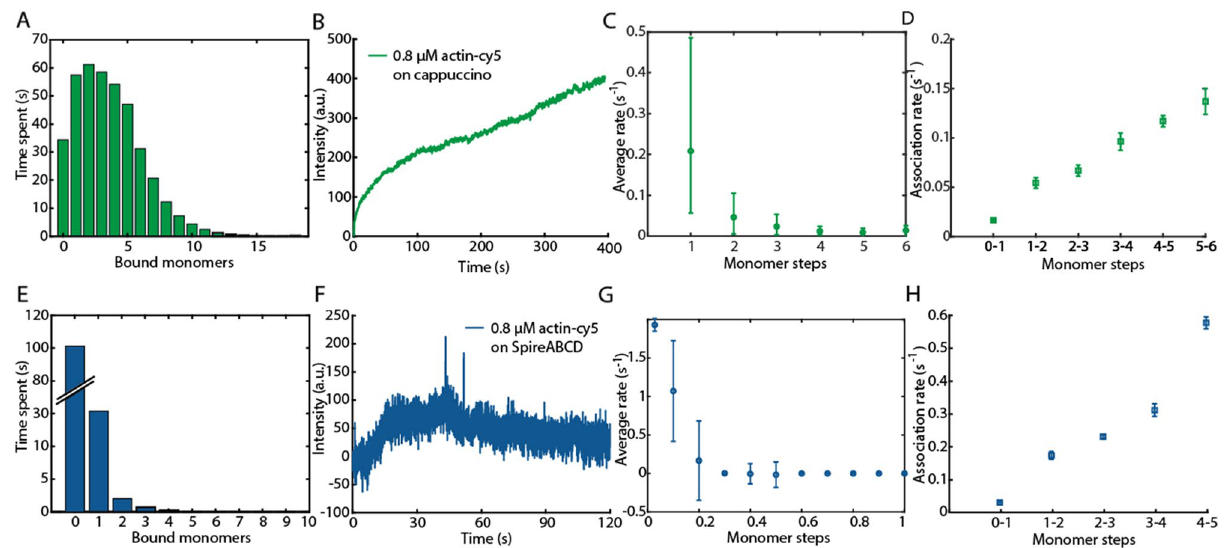
Figure 4. Experimental data of 30% stochastically labeled actin-Cy5 growing on Cappuccino and Spire-ABCD. A comparison between a visitation analysis, dwell-time analysis and average rate analysis is performed for the measurements with Cappuccino ( A – D , green) and Spire-ABCD ( E – G , blue). ( A , E ): The visitation analysis, ( B , F ) average intensity, ( C , G ) fractional average-rate analysis and ( D , H ) dwell-time analysis showing the first 5 monomer association steps from 700 individual traces are plotted. The fractional average rates have been calculated using the time until the average trace reached the intensity change corresponding to 0.1 monomers (i.e. between 0 and 0.1, between 0.1 and 0.2, between 0.2 and 0.3, etc.). Fractional average rates are 10 times faster than average rates because the average intensity of only 1/10 of a monomer has to be reached. The experimentally determined photobleaching rate was